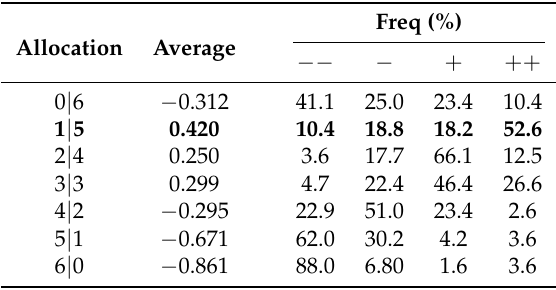
Table 2. Perceptions of